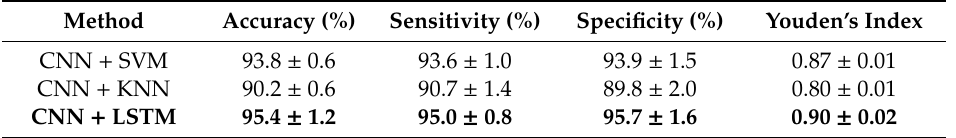
Table 2. Classification of 1 × 4096 feature vector obtained from CNN with support vector machine (SVM), K-nearest neighbors (KNN), and LSTM.